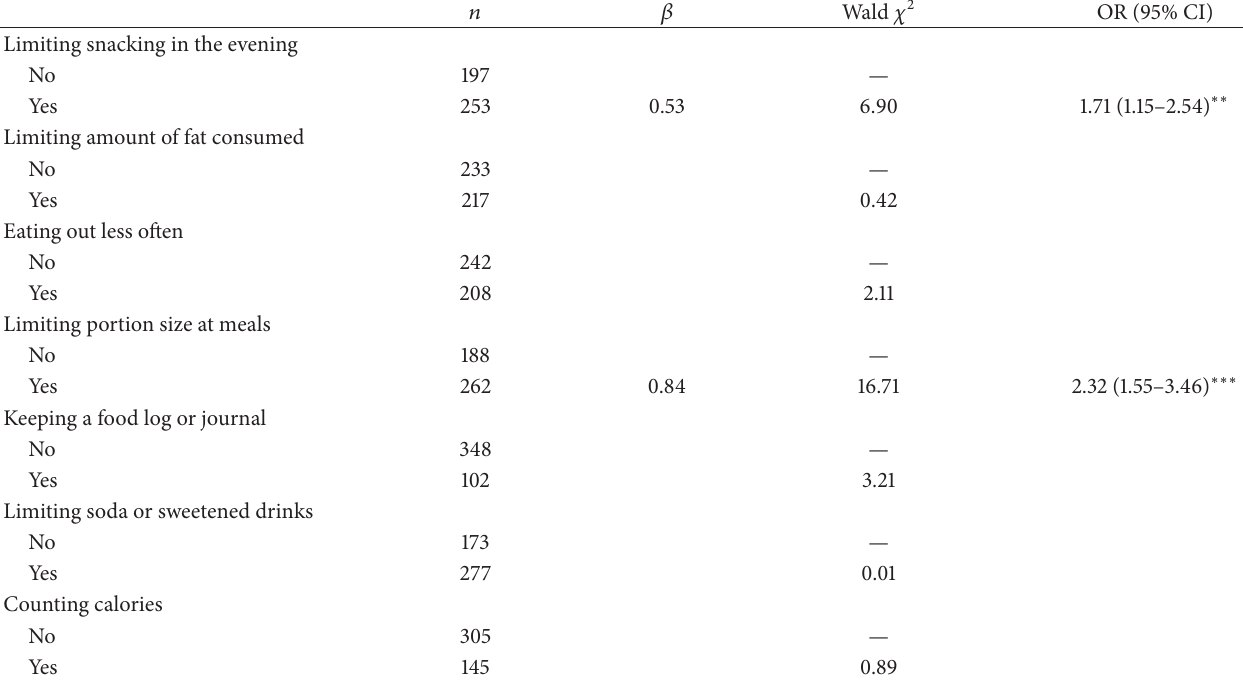
Table 5: Postprogram predictors of weight loss maintenance ( 𝑁 = 450 )—Model